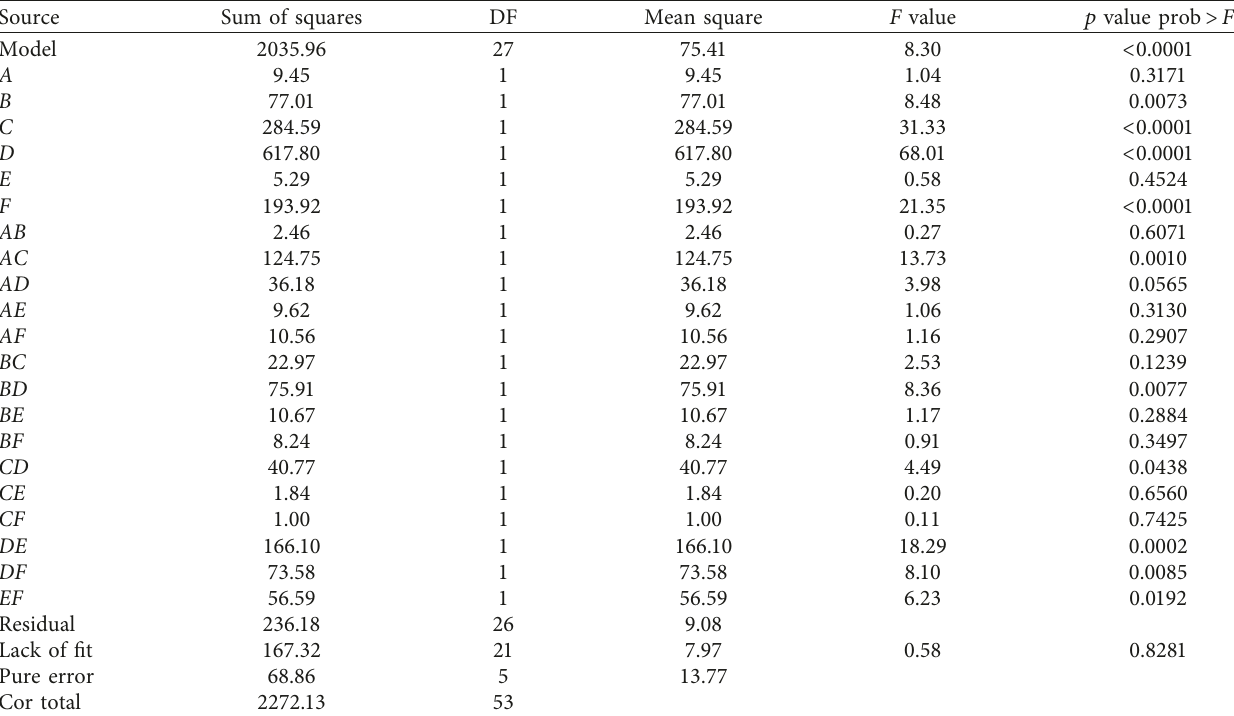
Table 5: Analysis of variance of